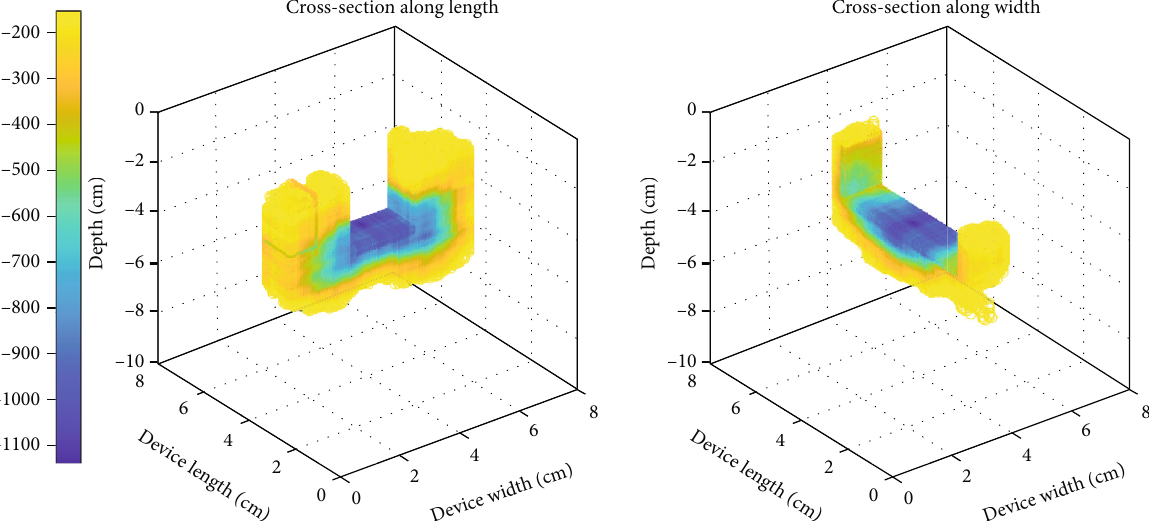
Figure 12: Cross-section from di ff erent directions of the in fl uence zone.